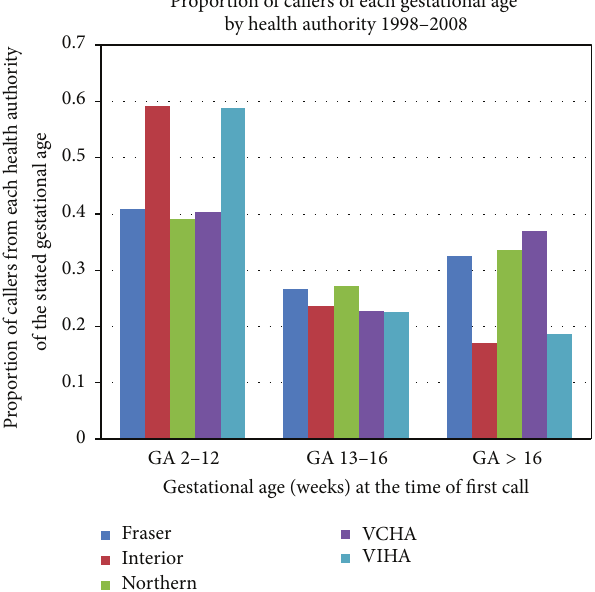
Figure 3: Proportion of callers of each gestational age by health authority, among those for whom the gestational age is known ( 𝑛 = 7092 ). Although in Canada pregnancies beyond 16-week gestational age at the time of termination are fewer than 5% of all induced abortions, they represent a significant proportion of the users of the pregnancy options toll-free